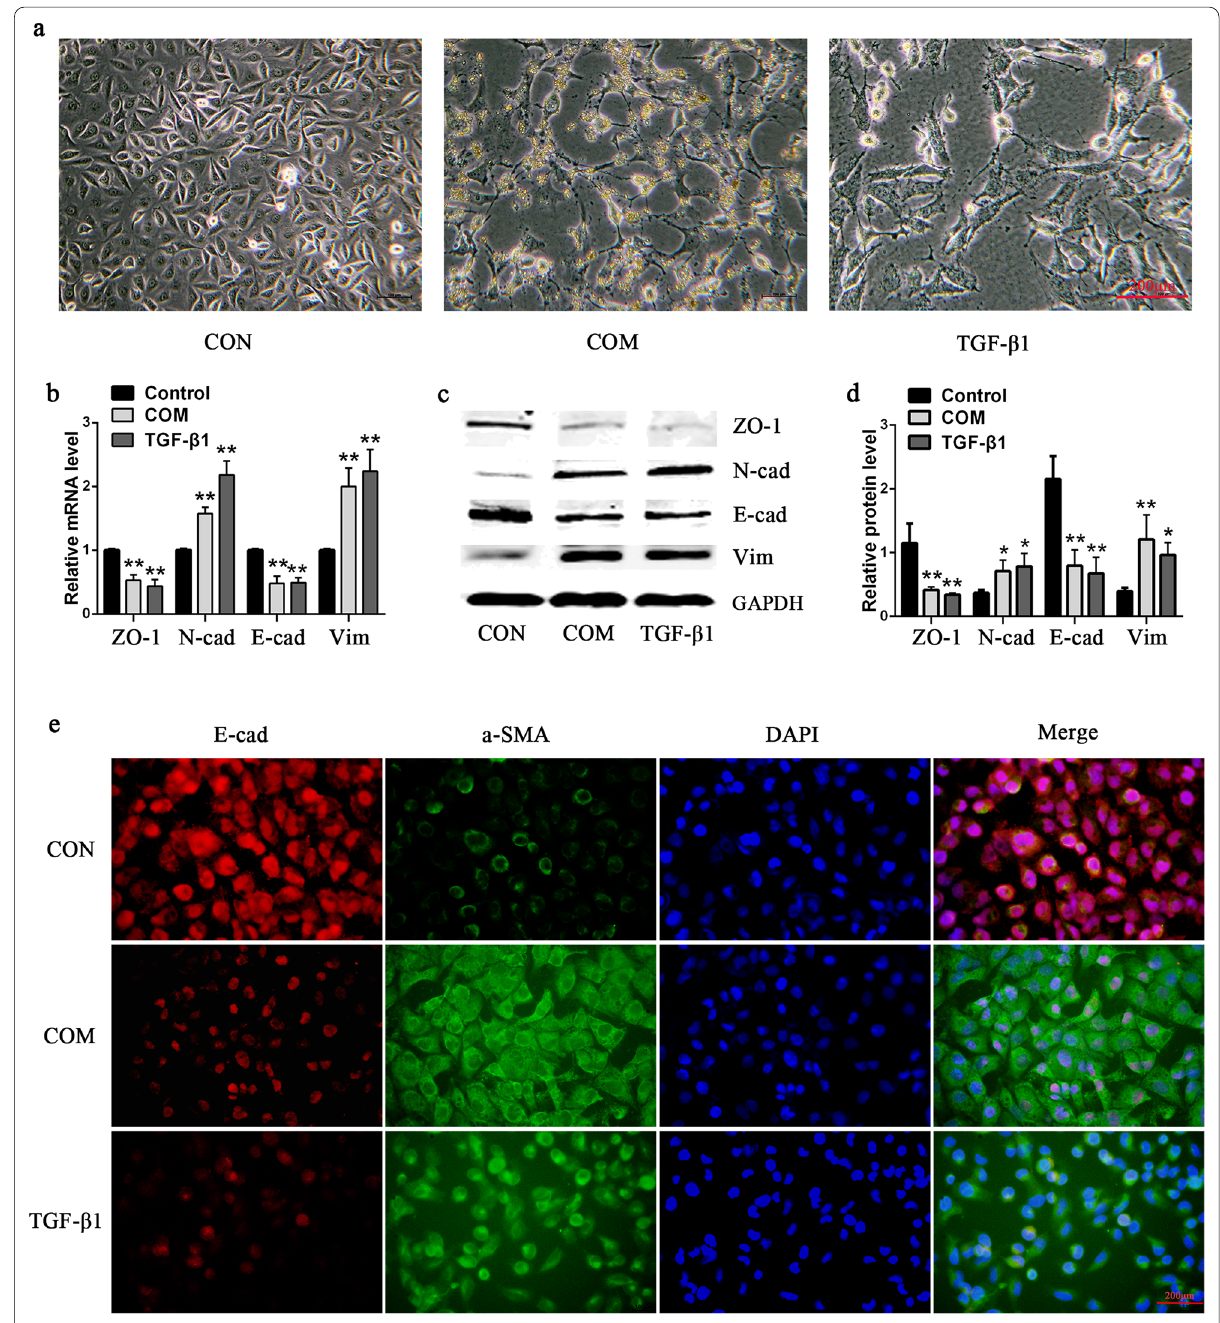
Fig. 2 Significant EMT changes of HK-2 cells exposed to COM or TGF-β1. a Morphological Changes of HK-2 cells exposed to 200ug/ml COM or 10 ng/ml TGF-β1 for 48 h under light microscope. b , c The mRNA b or protein c levels of EMT markers in HK-2 cells exposed to 200ug/ml COM or 10 ng/ml TGF-β1 for 48 h. d Quantitative results of EMT marker-protein levels. e The expression levels of E-cadherin and α-SMA were detected by immunofluorescence. All above the experiments were repeated 3 times, values are mean bars 200 =